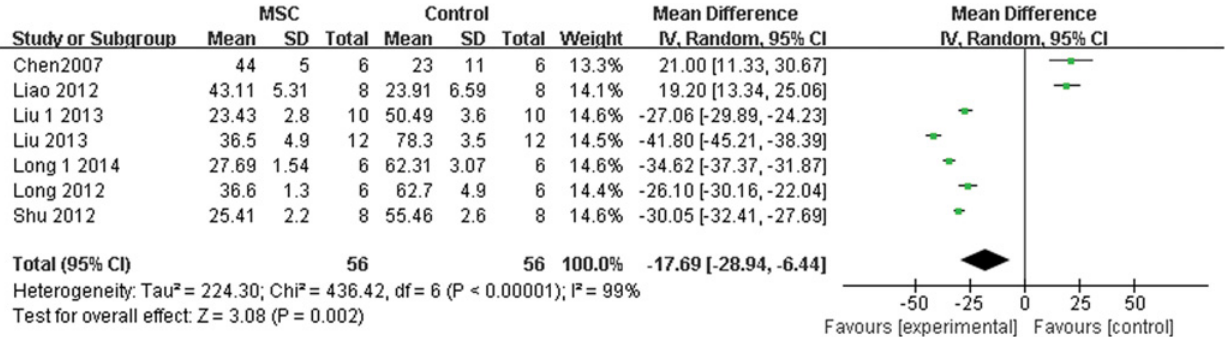
PLOS ONE | DOI:10.1371/journal.pone.0120082 March 26,